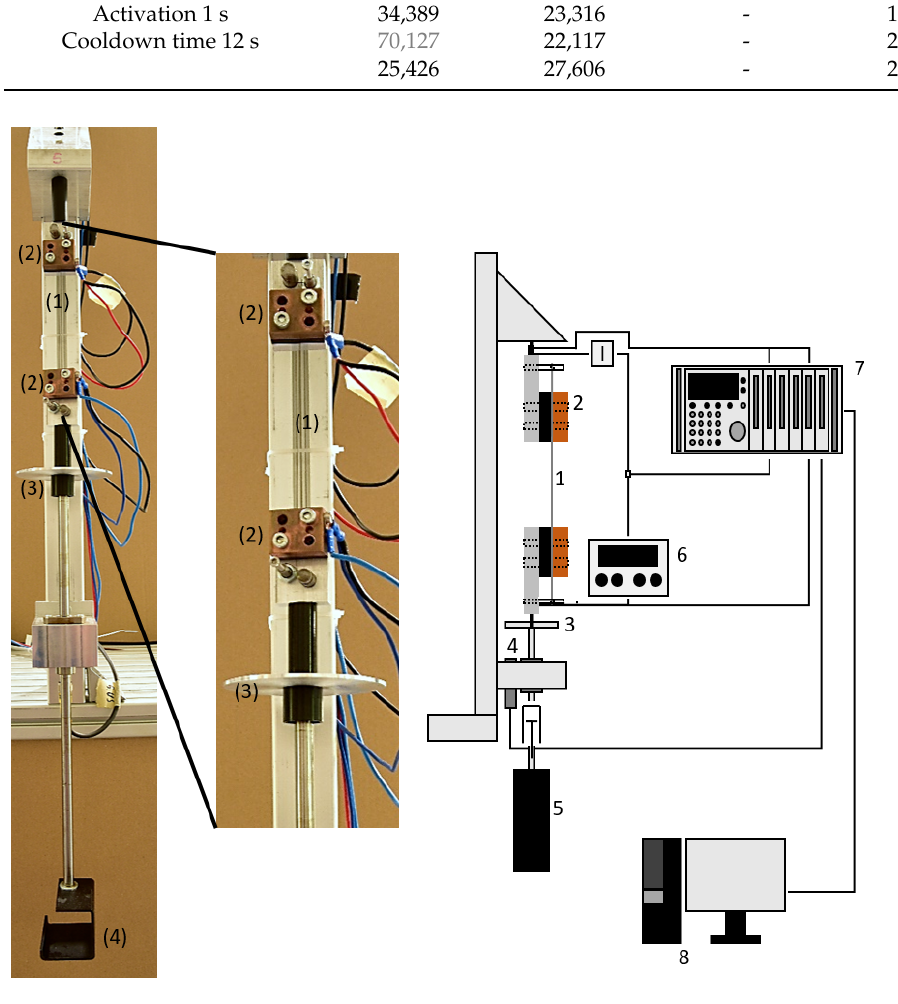
Figure 8. Second test rig for fatigue tests. Source: